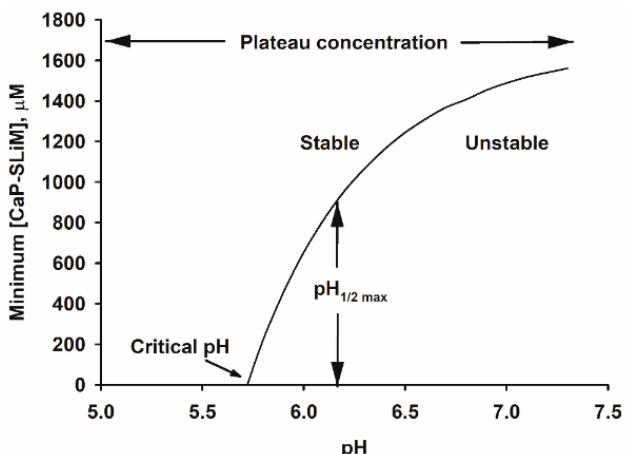
Figure 6. Stability diagram for a typical bovine milk. Above a critical pH the solution becomes supersaturated with respect to CaP and a certain minimum concentration of sequestering peptide or protein is required to maintain its stability. At or above this minimum concentration the milk is stable and below it is metastable or unstable and phase separation / precipitation of CaP can occur. At about pH 8, the curve separating the stable and unstable regions reaches a plateau concentration. The shape of the curve is further characterized by the pH where half the plateau concentration of sequestering protein is required for stability. Reprinted with permission from Holt et al. [13] © 2013The Authors. Published by Elsevier Inc. All rights reserved.